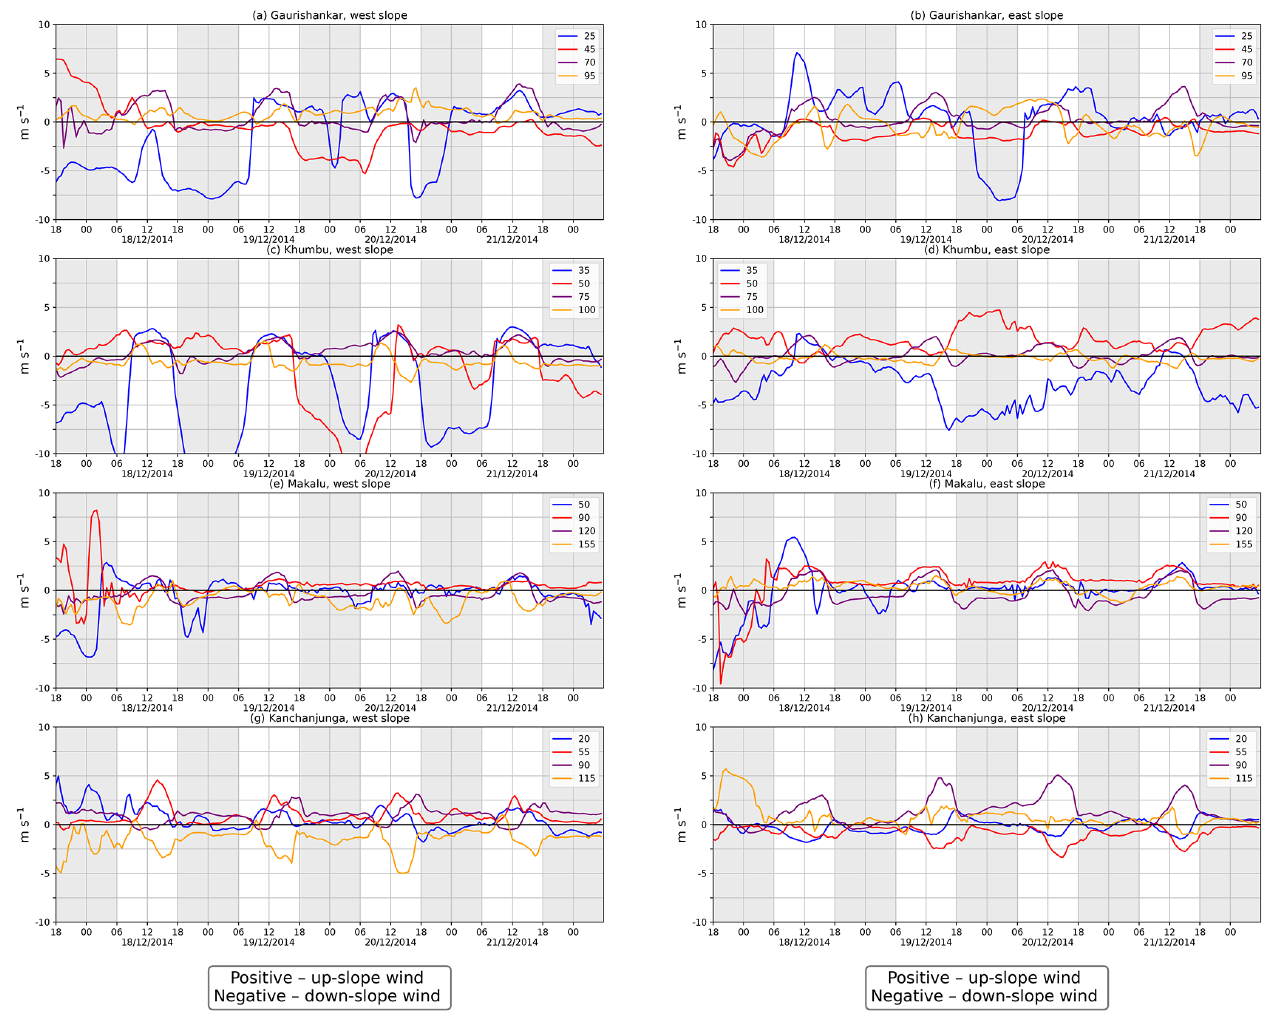
Figure 7. Cross-valley wind velocity in different parts of each of the four valleys (see Fig. 2b) on the lowest model level (approximately 25m above the surface). Panels (a) , (c) , (e) and (g) are for grid points located on the western slope of the valleys, and panels (b) , (d) , (f) and (h) are for grid points on the eastern slopes. Local time is shown on the x axes. The cross-valley wind component on the western slope is multiplied by − 1 to present both slopes such that positive values refer to an up-slope wind. The data are plotted every